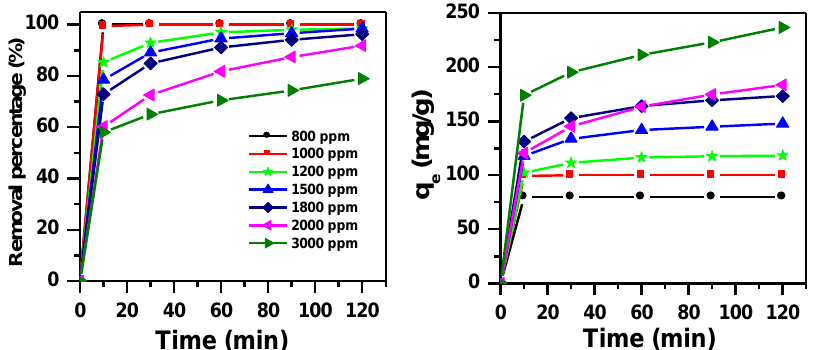
Figure 3. Effect of pH on the removal efficiency of MB using MNS-4 (C i = 800 ppm, m adsorbent = 1 g, contact time = 30 min).